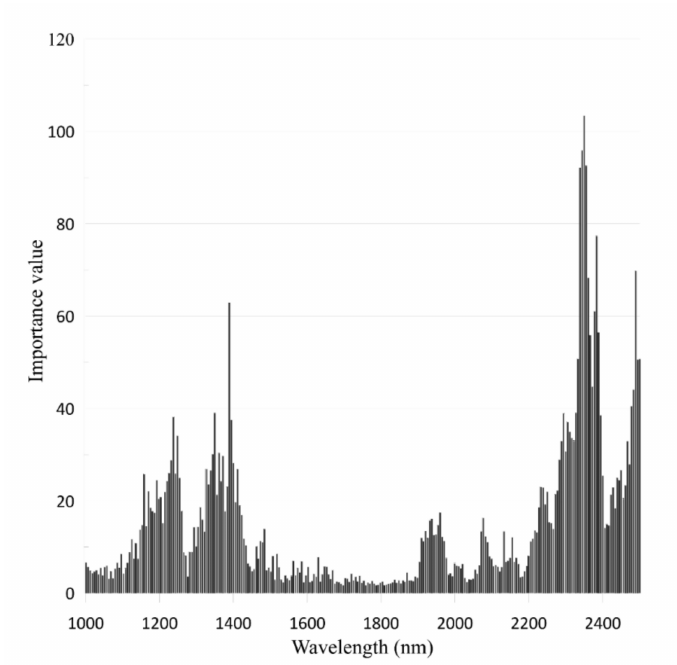
Figure 6. The importance values of spectral bands derived from the random forest (RF) method.